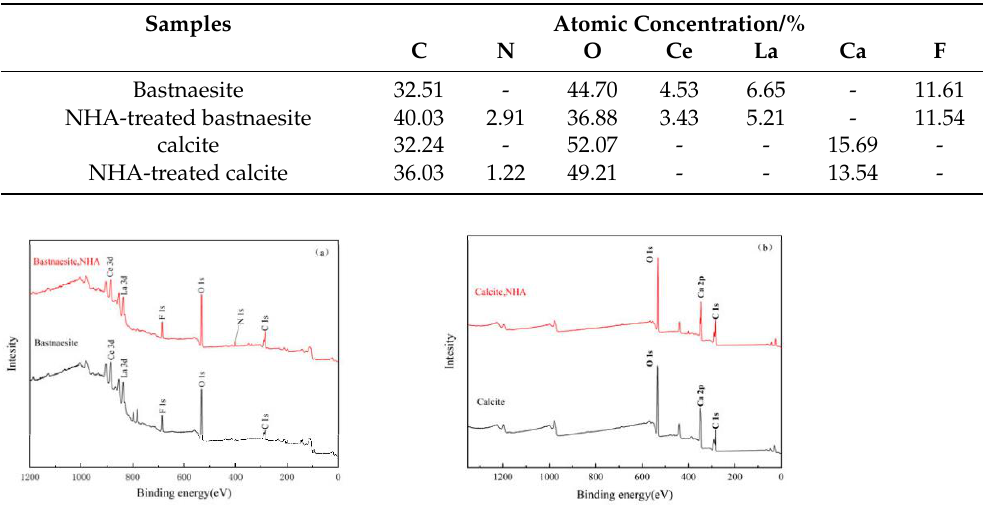
Figure 7. FTIR spectra of pure, NHA-treated bastnaesite ( a ) and pure, 2-OH-3-NHA-treated calcite ( b ).